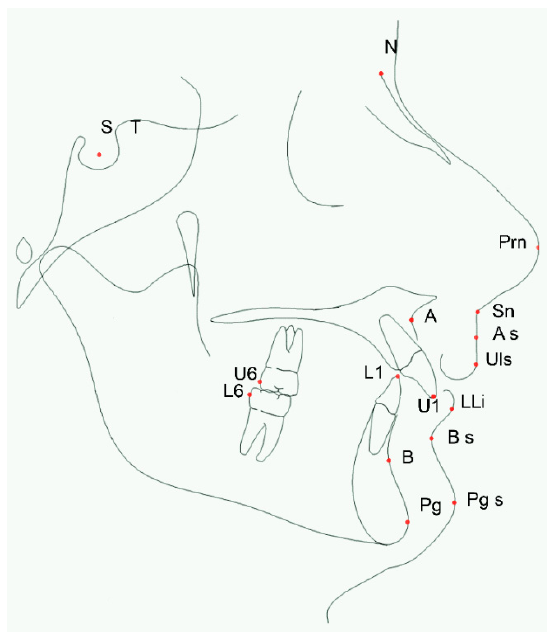
Figure 2. Cefalometric measuring points.